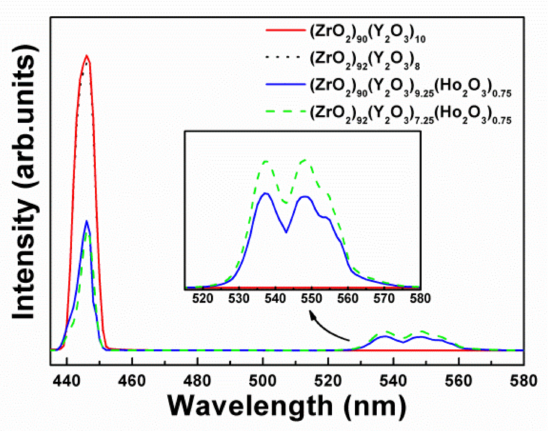
Figure 7. Luminescence spectra for (ZrO 2 ) 90 (Y 2 O 3 ) 10 , (ZrO 2 ) 92 (Y 2 O 3 ) 8 , (ZrO 2 ) 92 (Y 2 O 3 ) 7.25 (Ho 2 O 3 ) 0.75 , and (ZrO 2 ) 90 (Y 2 O 3 ) 9.25 (Ho 2 O 3 ) 0.75 crystals under the excitation at 446 nm. Figure 7 indicated that there was an absorption band from 434 to 460 nm and a green light emission band from 521 to 575 nm in the luminescence spectra of (ZrO 2 ) 92 (Y 2 O 3 ) 7.25 (Ho 2 O 3 ) 0.75 and (ZrO 2 ) 90 (Y 2 O 3 ) 9.25 (Ho 2 O 3 ) 0.75